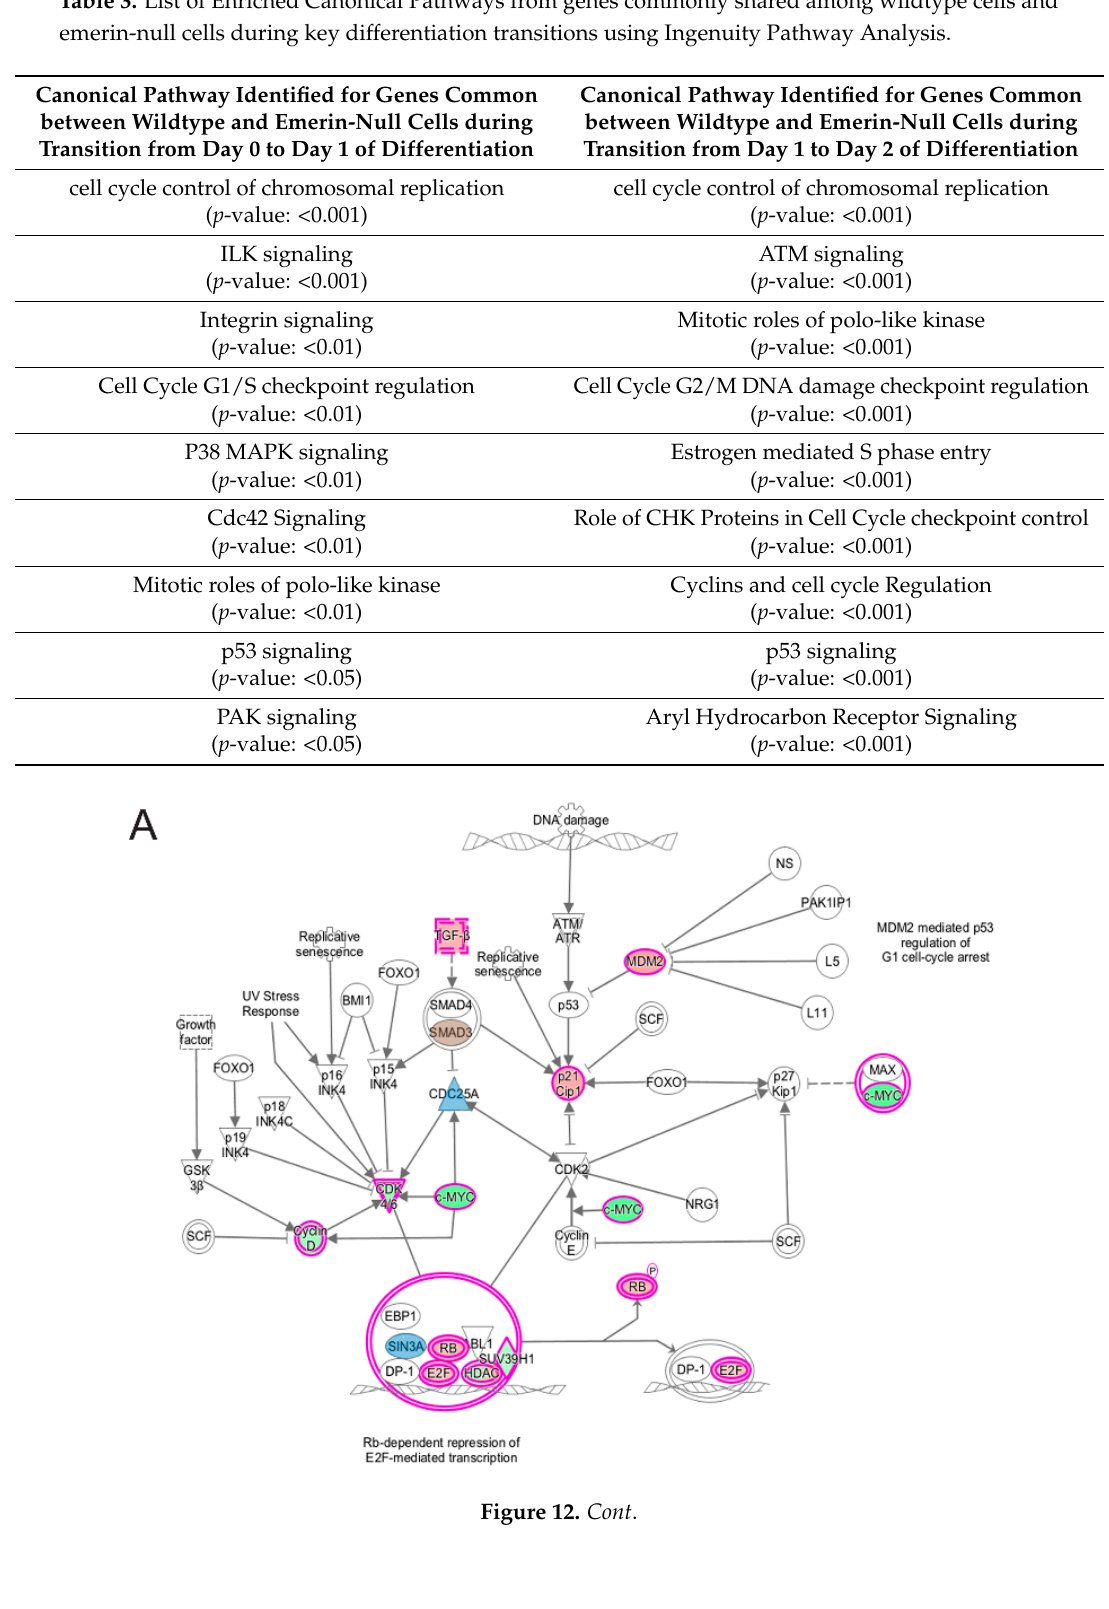
Figure 12. Ingenuity pathway analysis of genes differentially expressed during the transition from differentiation day 0 to day 1 common to emerin-null cells and wildtype cells. ( A ) The Cell Cycle G1/S checkpoint regulation pathway is significantly enriched in both wildtype and emerin-null cell during transition from day 0 to day 1 of differentiation. The network was generated through the use of IPA (Ingenuity Systems, www.ingenuity.com) on normalized mRNA values. Nodes represent molecules in a pathway, while the biological relationship between nodes is represented by a line (edge). Edges are supported by at least one reference in the Ingenuity Knowledge Base. The intensity of color in a node indicates the degree of up- (red) or down- (green) regulation. Brown colored nodes (up- regulation) and blue colored nodes (down-regulation) indicate additional nodes in the pathway that are uniquely altered in emerin-null cells. Nodes are displayed using shapes that represent the functional class of a gene product (Circle = Other, Nested Circle = Group or Complex, Rhombus = Peptidase, Square = Cytokine, Triangle = Kinase, Vertical ellipse = Transmembrane receptor). Edges are marked with symbols to represent the relationship between nodes (Line only = Binding only, Flat